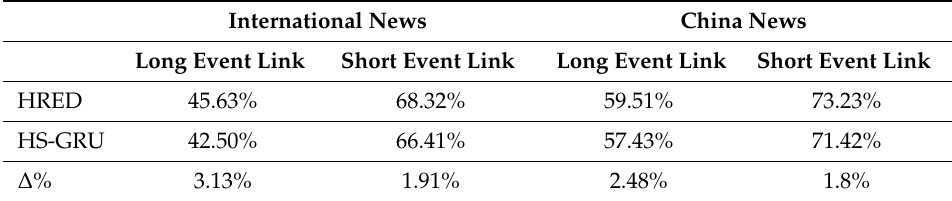
Table 4. Error rate for events link with different length.